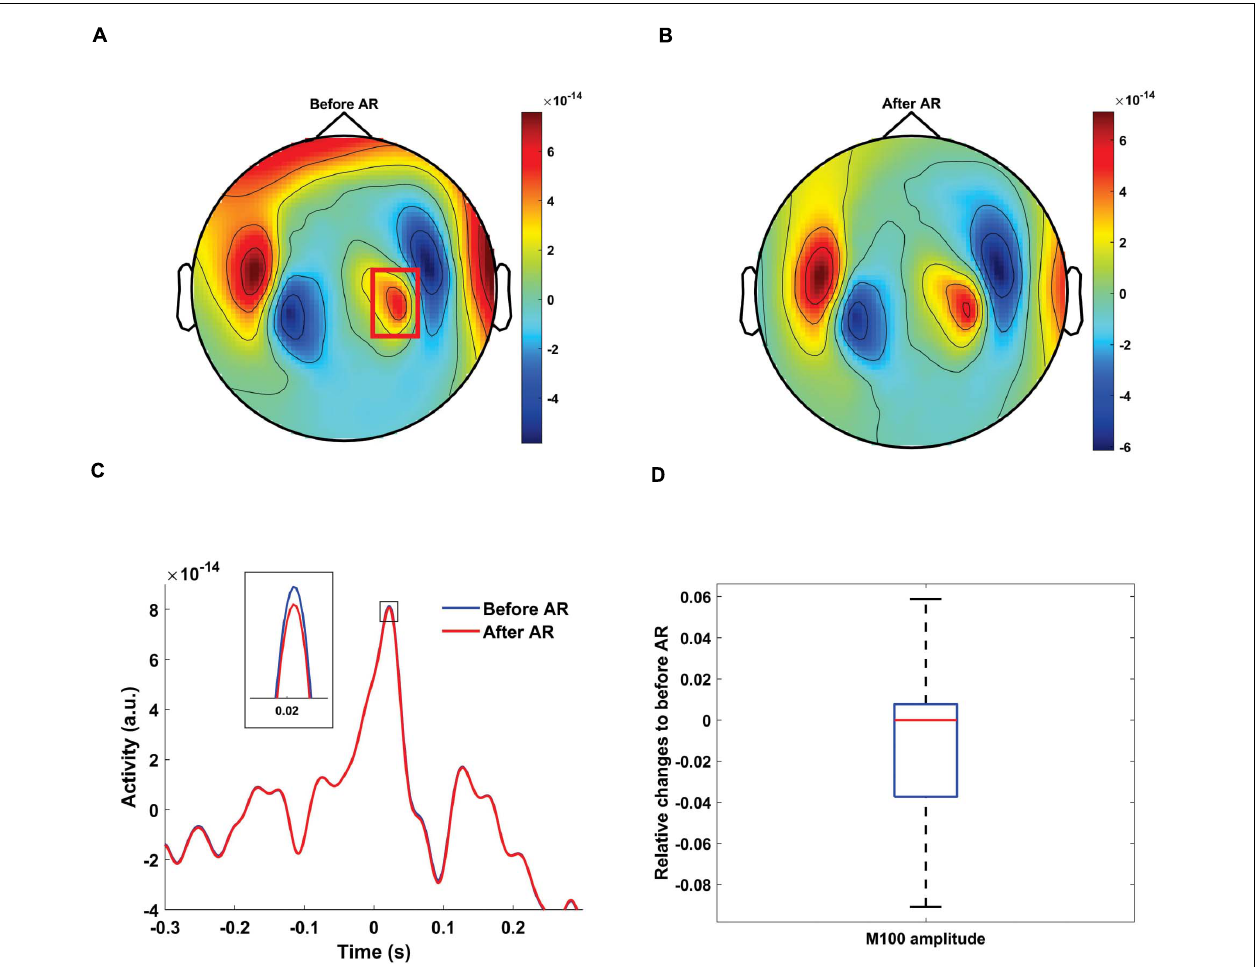
FIGURE 8 | MEG artifact rejection on syllables perception condition. Topographic distribution of MEG amplitude between –20 and 70 ms before (A) and after cleaning data using spatial filters constructed from speech production dataset (B) for participant #9 of EXP2. Color codes MEG amplitude. (C) Grand average of the time-series from the MEG sensors, designated by a red rectangle, from participant #9 before (blue) and after (red) artifact rejection. The proposed artifact rejection caused negligible M100 amplitude reduction. (D) Boxplots showing the distribution of the relative change of individual M100 amplitudes after artifact rejection relative to before artifact rejection condition for all the participants in EXP2 (AR, artifact